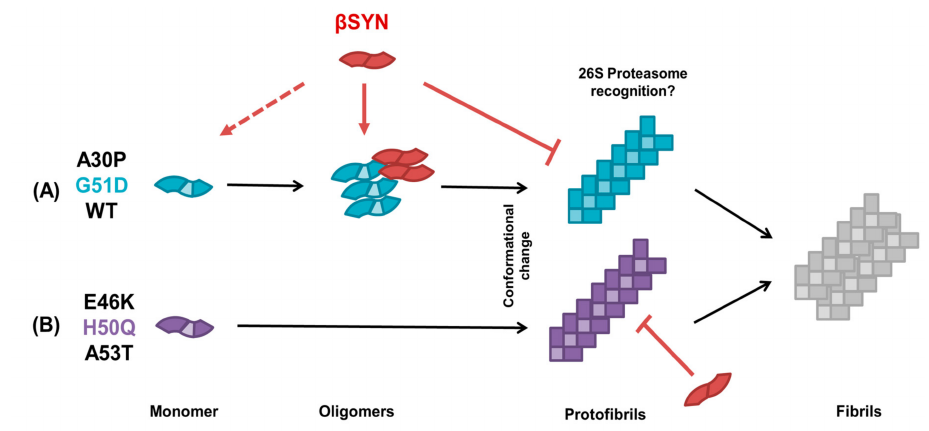
Figure 6. Proposed model of modulation of α -synuclein aggregation by its putative “natural negative regulator” β -synuclein. The model shows two distinct pathways of aggregation for the different α S mutants, in ( A ) and ( B ). α S monomers are depicted as blue and purple coloured blocks with a light-coloured core representing the NAC domain, which is absent in β S, represented by red blocks. Arrows represent the proposed model’s sequence; dashed lines represent discussion points in this model for future studies; capped ends depict no interaction. Monomeric and oligomeric forms are represented unfolded, and a conformational change is required for α -synuclein to display pre-fibrillar and fibrillar